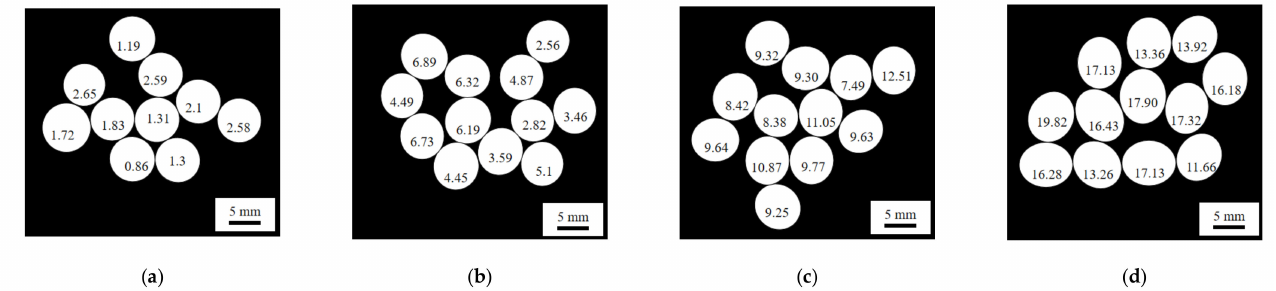
Figure 13. Recognition results of different shapes of pearls under different contact posture conditions. ( a ) Perfect circle; ( b ) Circle; ( c ) Near circle; ( d )